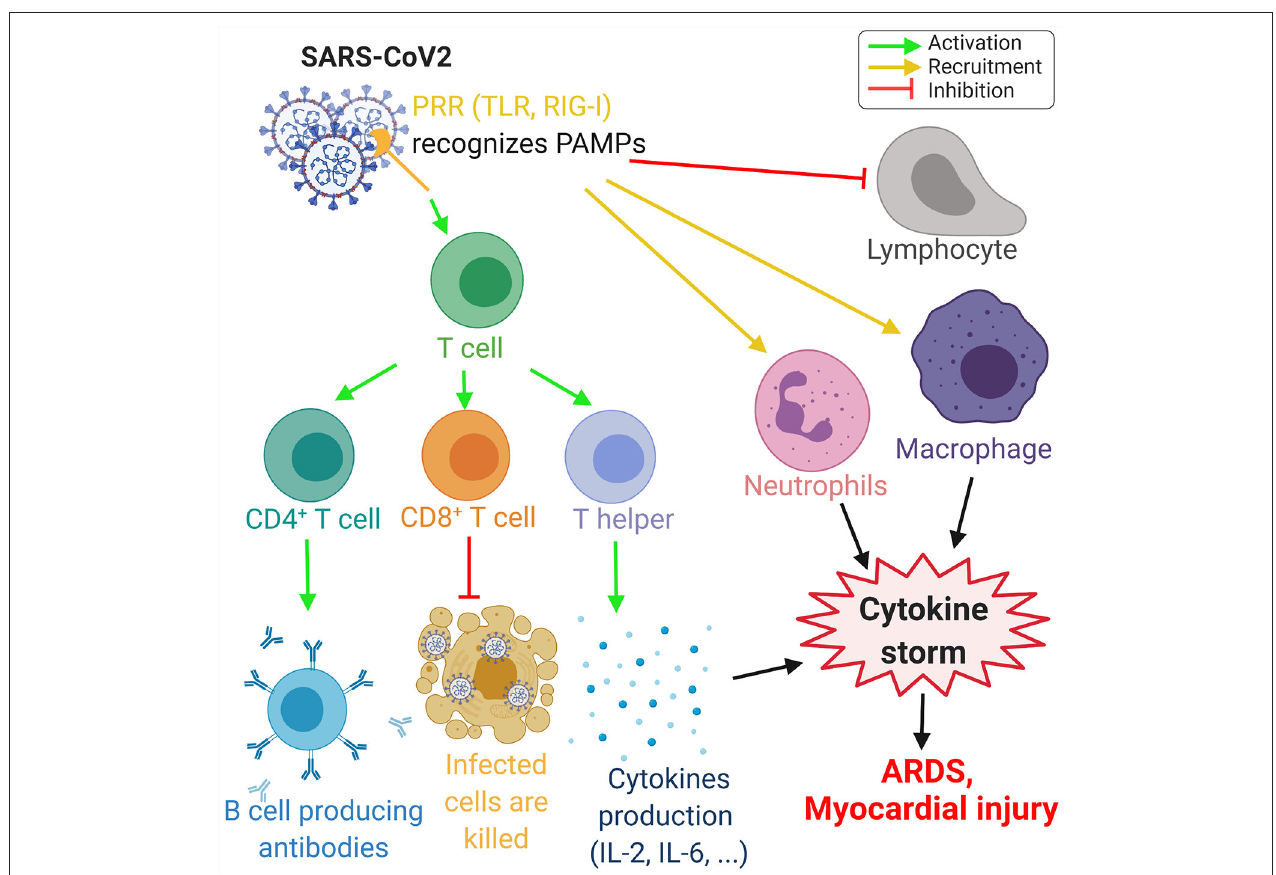
FIGURE 3 | Overview of the immune response to COVID-19. The proteins on SARS-CoV-2 membrane are recognized as pathogen-associated molecular pattern by the pattern recognition receptors (PRRs), such as Toll-like receptors (TLR) and retinoic acid-inducible gene-I (RIG-I)-like receptors. This recognition leads to the activation of T-cells, which differentiate in CD4 + T-cells, CD8 + T-cells, and T-helper cells that induce, respectively, the production of antibodies by B-cells, the deaths of infected cells, and the cytokine production, such as interleukins IL-2 and IL-6. Moreover, SARS-CoV-2 invasion leads to the recruitment of neutrophils and macrophage and induce a lymphopenia. The increase of neutrophils and macrophages associated with the cytokine production leads to a hyperinflammation called the cytokine storm. This cytokine storm leads to acute respiratory distress syndrome (ARDS) and myocardial damage. Green arrows refer to activating effects, orange arrows refer to recruitment effects, and the red lines refer to inhibiting effects (figure created with